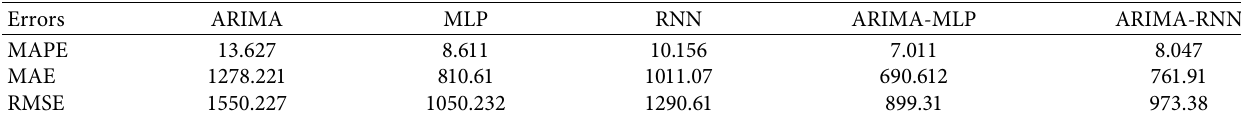
Table 3: Forecasting performance of different